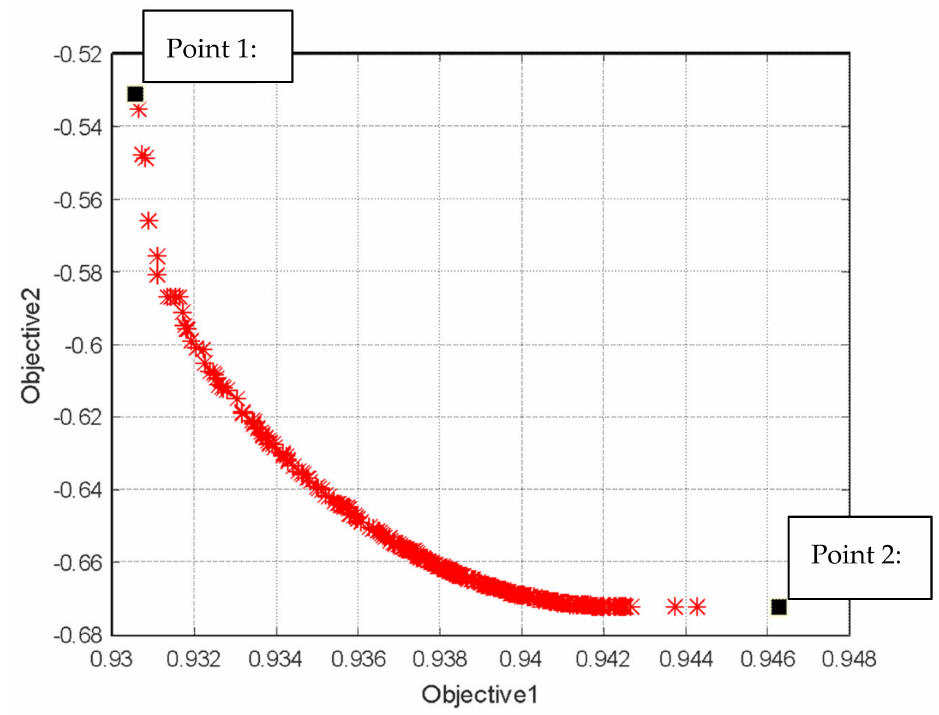
Figure 7. The Pareto front of the design optimization